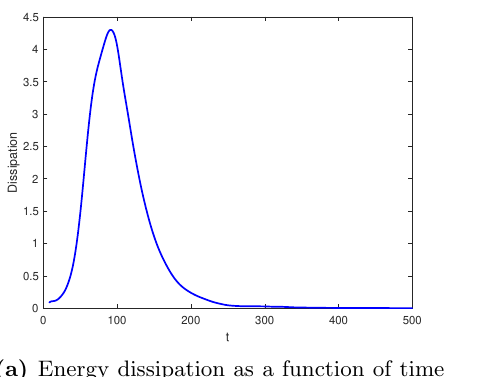
when the lattice consists of 19 vortices. Figure 7. Energy dissipation when R = 12.